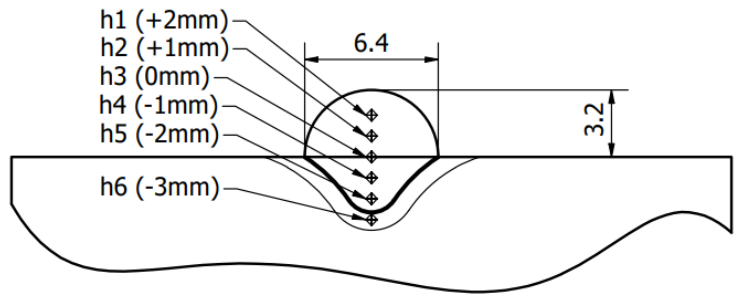
Figure 6. Diagram of hardness measurement.